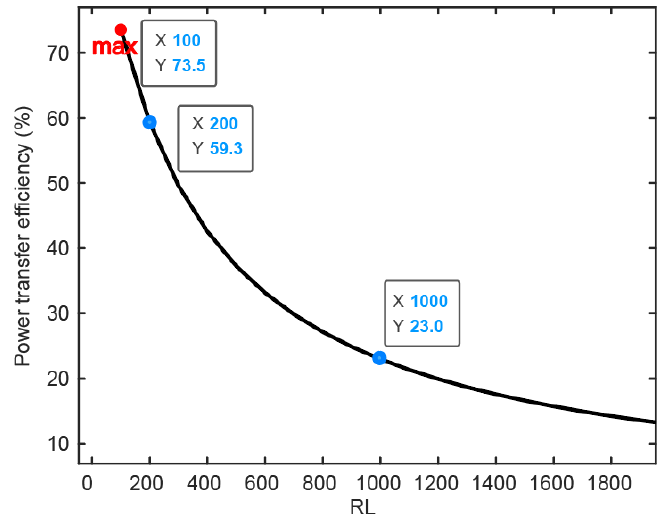
Figure 9. COMSOL-based simulation results of the magnetic field coupling link show the power transfer efficiency related to the load